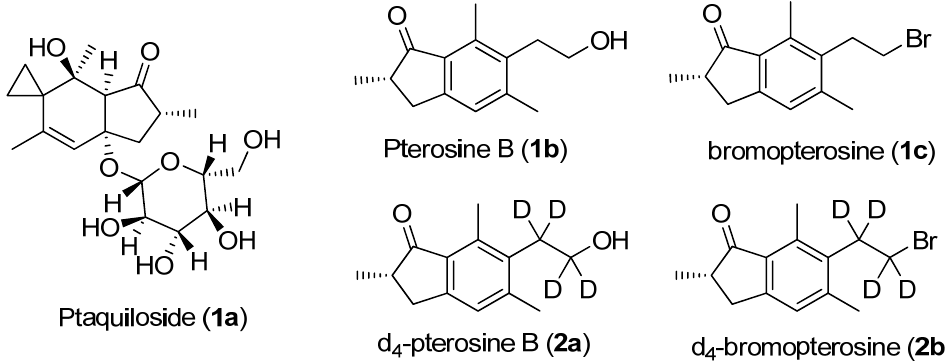
Figure 1. The structure of ptaquiloside, pterosin B, bromopterosin, d d 4